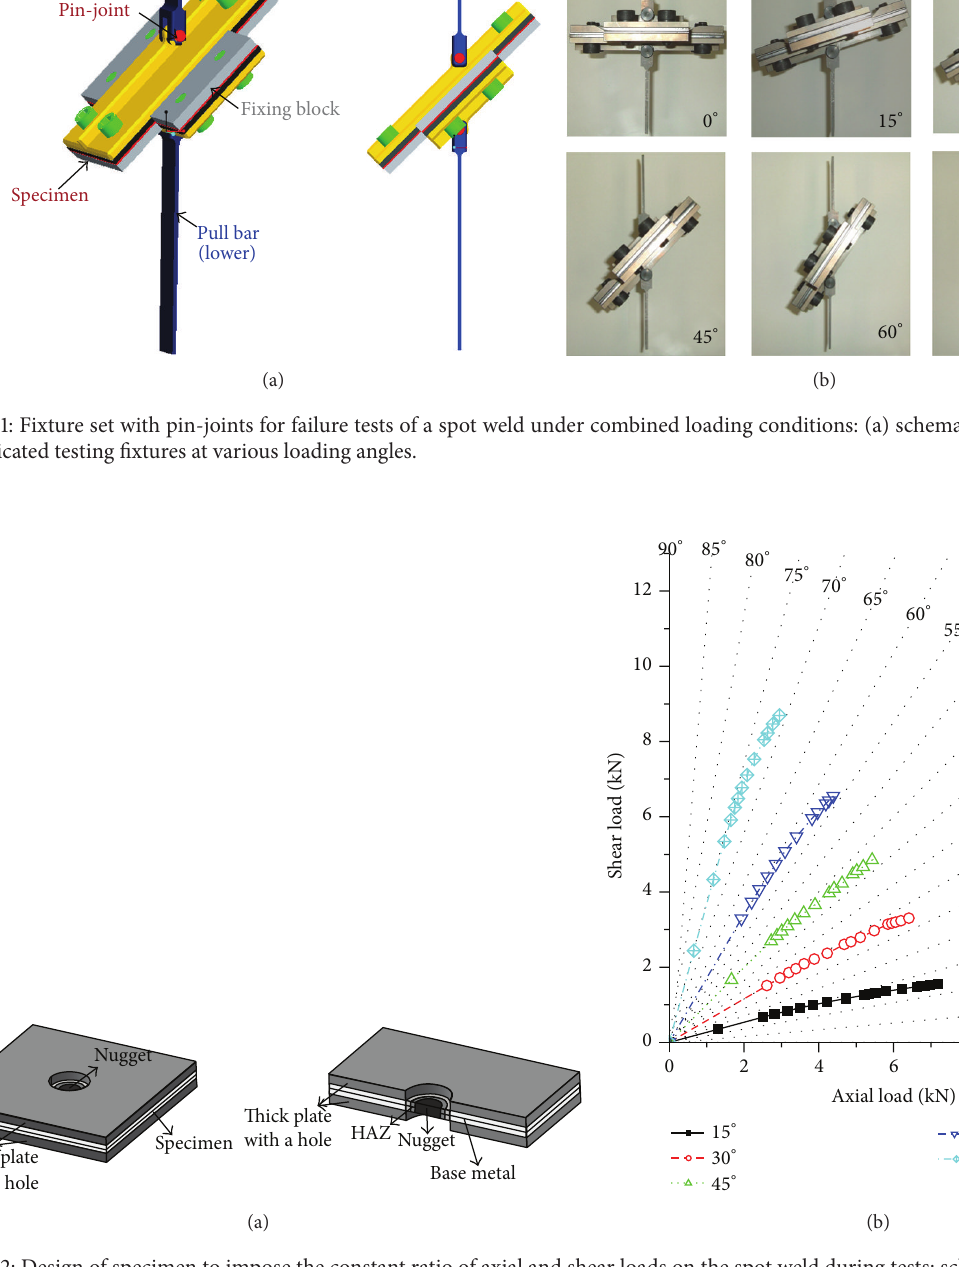
Figure 2: Design of specimen to impose the constant ratio of axial and shear loads on the spot weld during tests: schematic description of a specimen with a guide plate; (b) loading path acting on the spot weld at various loading angles (FEM